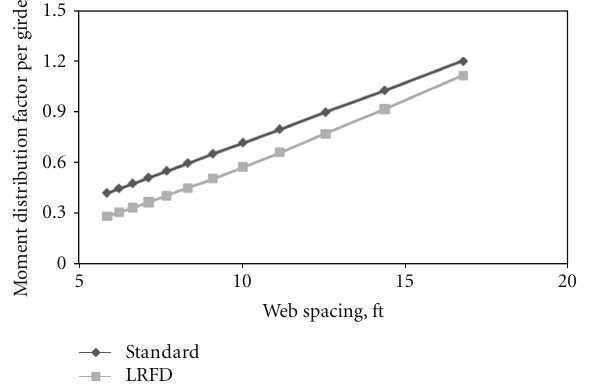
Figure 8: Superstructure cost and optimum web